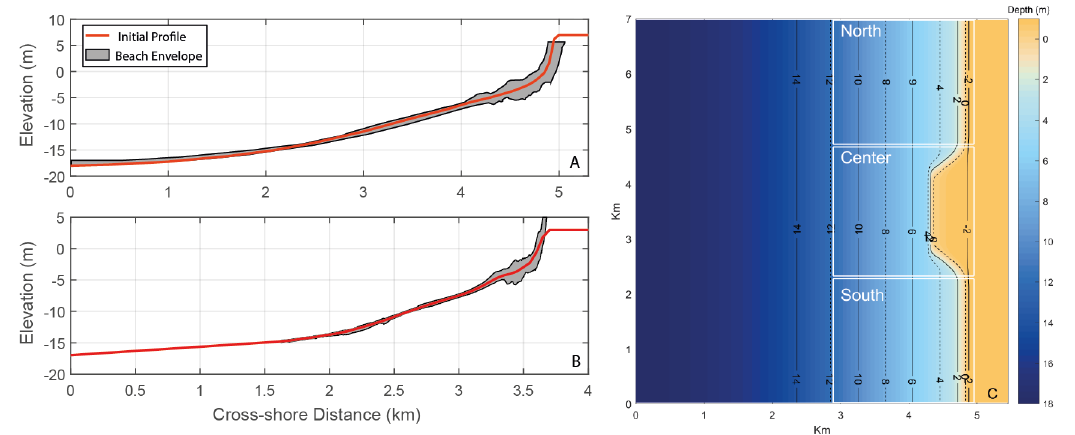
Figure 1. Initial time-space averaged modelling bathymetries and measured beach profiles represented as the overall beach envelope. Measured minimum and maximum coastal profile depths (gray) at Katwijk, the Netherlands ( A ), and Duck, USA ( B ). The smoothed average bed levels (red) correspond with the maps of uniform bathymetry in alongshore direction and were implemented into the numerical model. ( C ) Implementation of an idealized coastal hump into the Katwijk Dutch coastal